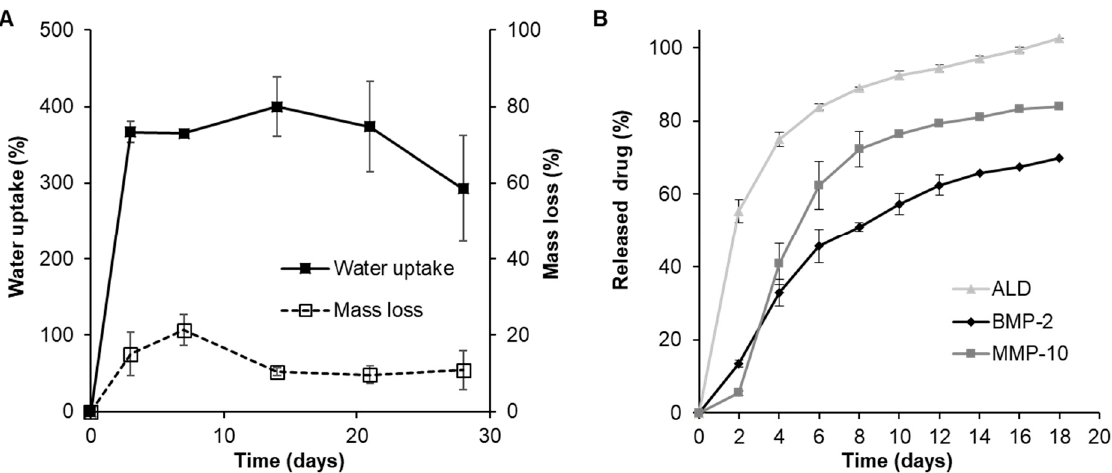
Figure 3. ( A ) Water uptake and mass loss and ( B ) drug release profiles of microsphere-loaded chitosan foams.